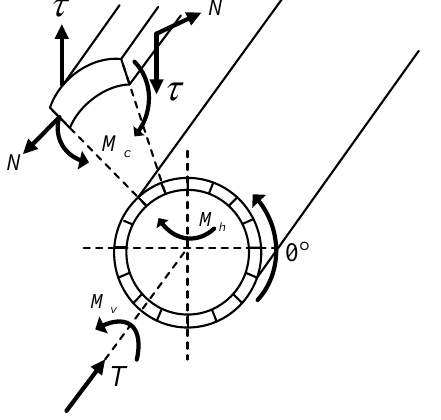
Figure 12. Schematic diagram of lining axial force, shear force and bending moment.